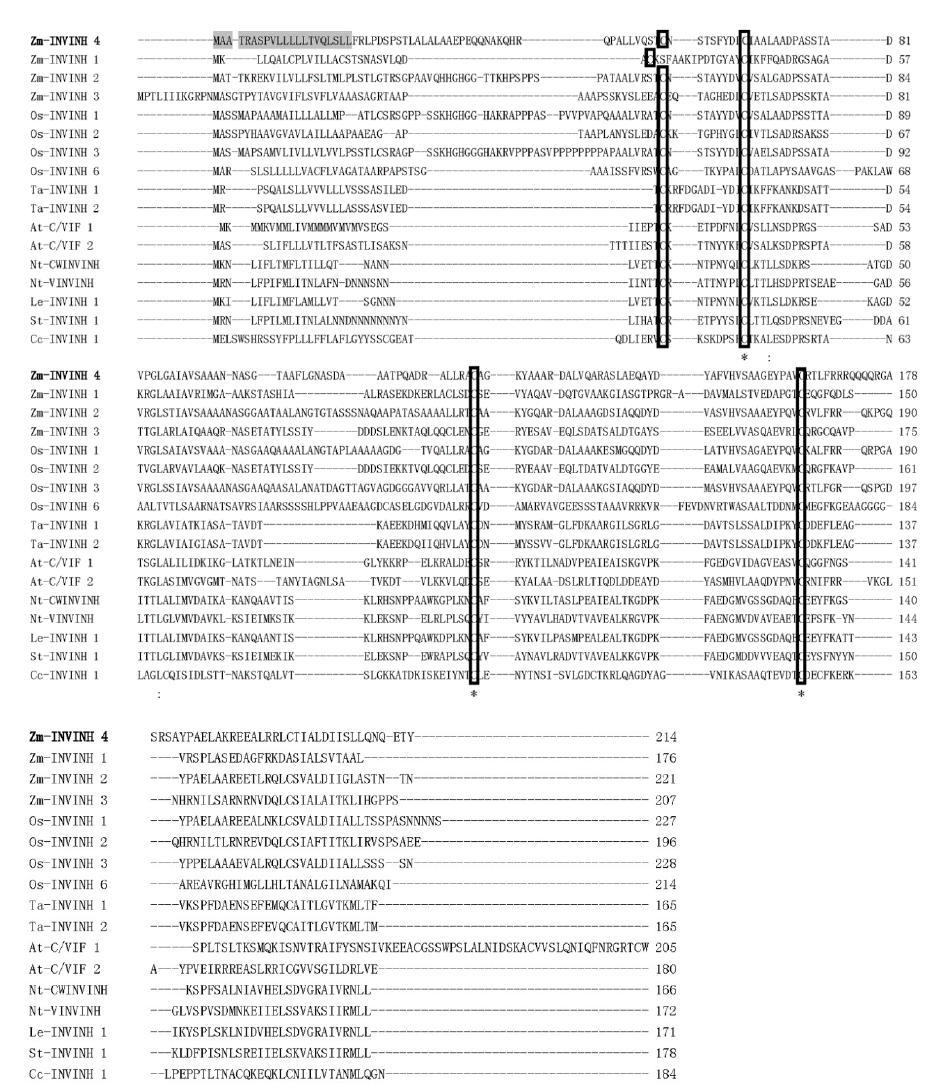
Figure 1. Comparison of the maize cell wall invertase inhibitor 4 (Zm-INVINH4) protein sequence with other invertase inhibitor-like proteins. Alignment of the deduced amino acid sequence of INVINH-like proteins from maize, rice, wheat, Arabidopsis, tobacco, tomato, potato, and coffee. The conserved four Cys residues are indicated by the rectangle. Identical and conserved residues are marked with asterisks and dots/colons, respectively. Shaded regions indicate the potential signal peptide cleavage site of Zm-INVINH4. The accession numbers of the sequences used to construct the alignment were: Y12805 (tobacco cell wall invertase inhibitor (Nt-CWINVINH)), Y12806 (tobacco vacuolar invertase inhibitor (Nt-VINVINH)), NM_103692 (Arabidopsis cell wall/vacuolar invertase inhibitor 1 (At-C/VIF1)), NM_125858 (At-C/VIF2, Arabidopsis cell wall/vacuolar invertase inhibitor 2), GRMZM2G162447 (maize cell wall invertase inhibitor 1 (Zm-INVINH1)), AX214336 (maize cell wall invertase inhibitor 2 (Zm-INVINH2)), AX214357 (maize cell wall invertase inhibitor 3 (Zm-INVINH3)), AJ010943 (tomato invertase inhibitor (Le-INVINH1)), NM_001067338 (rice invertase inhibitor 1 (Os-INVINH1)), NM_001049399 (rice invertase inhibitor 2 (Os-INVINH2)), AX214360 (rice invertase inhibitor 3 (Os-INVINH3)), NM_001071560 (rice invertase inhibitor 6 (Os-INVINH6)), FJ810208 (potato invertase inhibitor (St-INVINH1)), DQ834320 (coffee invertase inhibitor (Cc-INVINH1)). Two wheat invertase inhibitor (Ta-INVINH1 and Ta-INVINH2) amino acid sequences were found in the paper